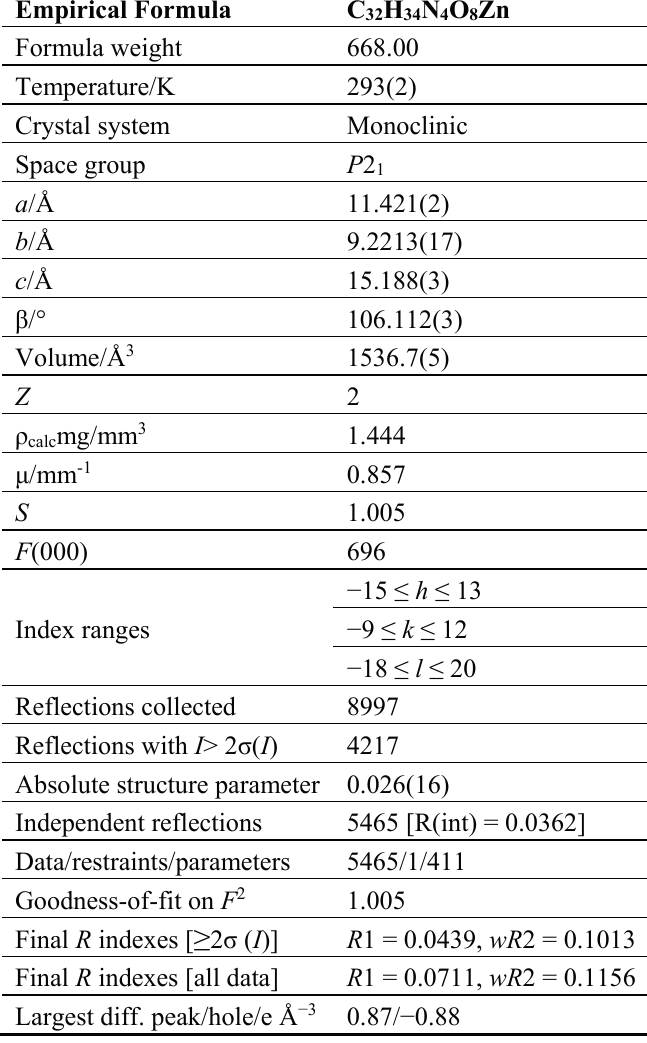
Table 2. Summary of crystalresult for Mg(II)